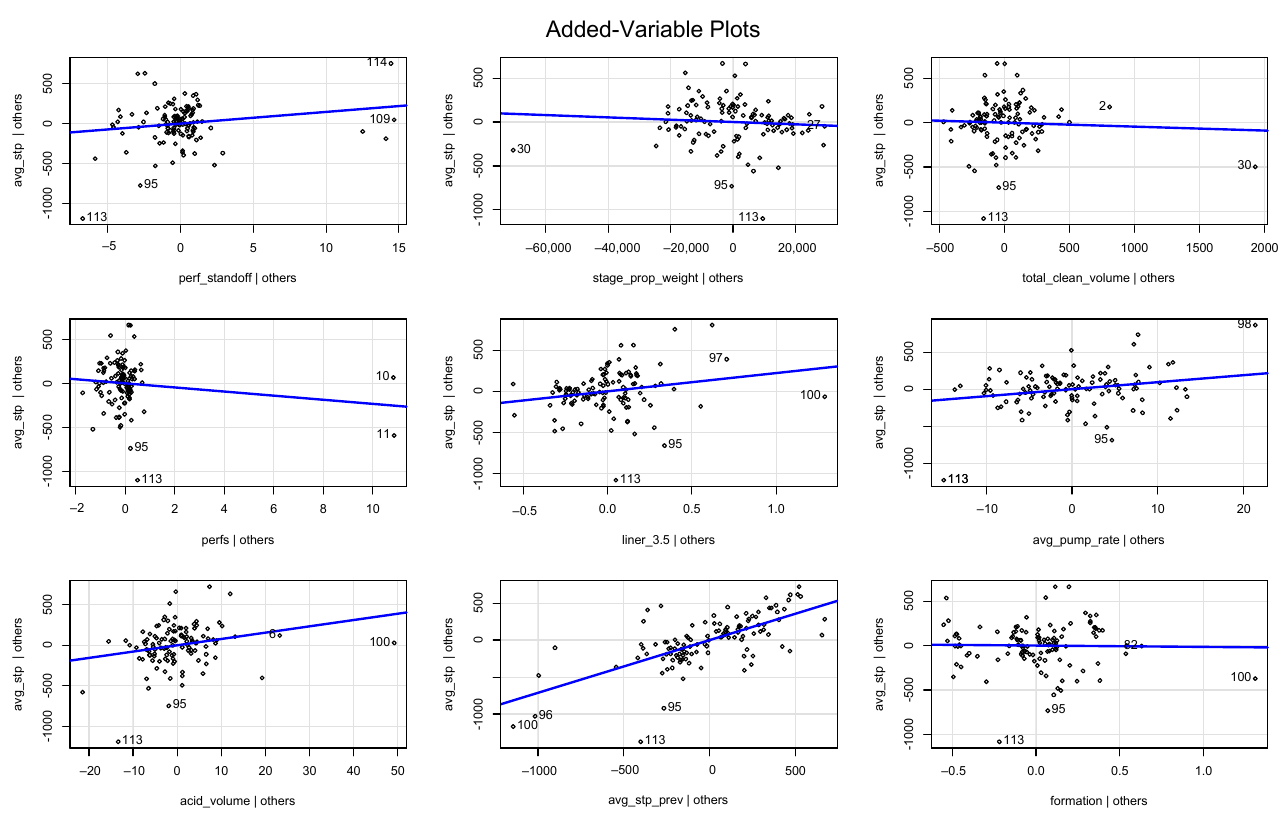
Figure 5. AV plots for model 2 showing the relationship for each independent variable with all others held constant.